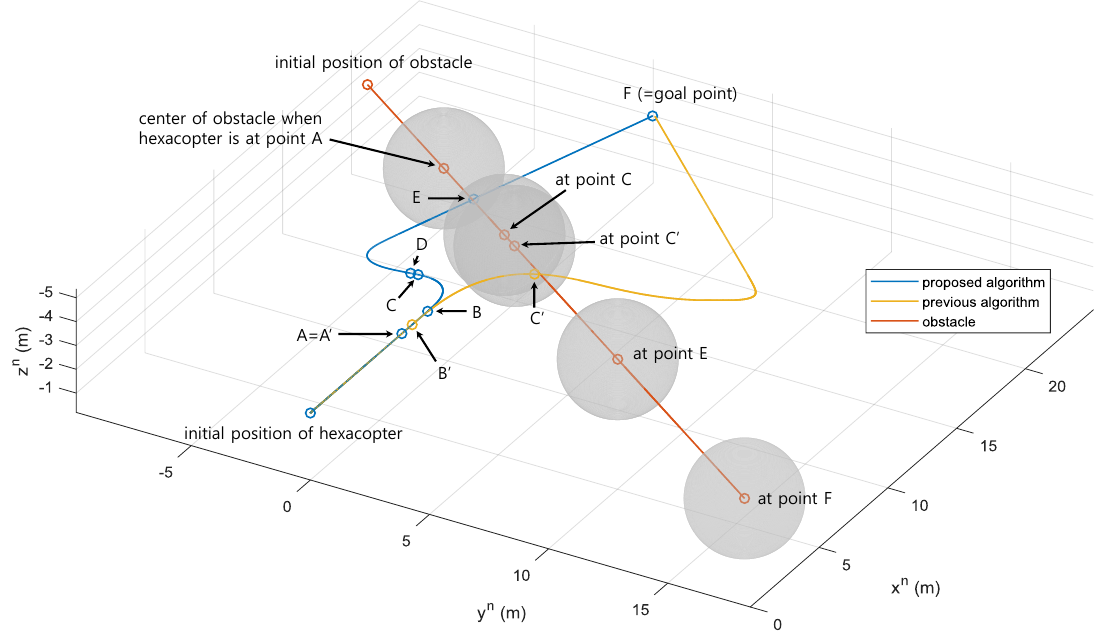
Figure 9. Trajectories of the hexacopter and the obstacle (azimuth: − 60 ◦ , elevation: 30 ◦ , Simulation